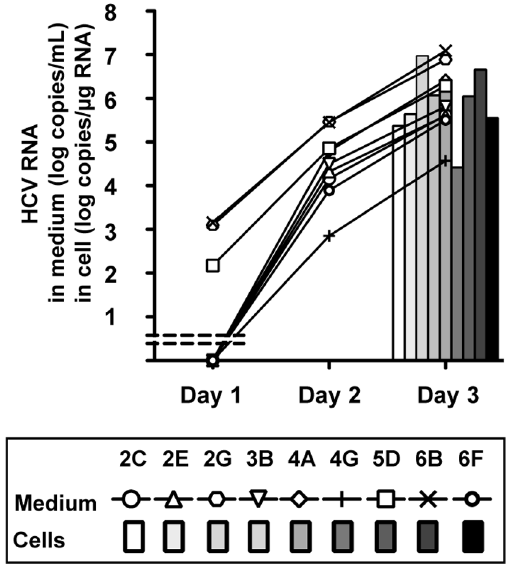
Figure 6. Production of progeny virus after infection of culture media harvested in wells that have a single focus. HCV RNA titers were measured in culture medium and cells.